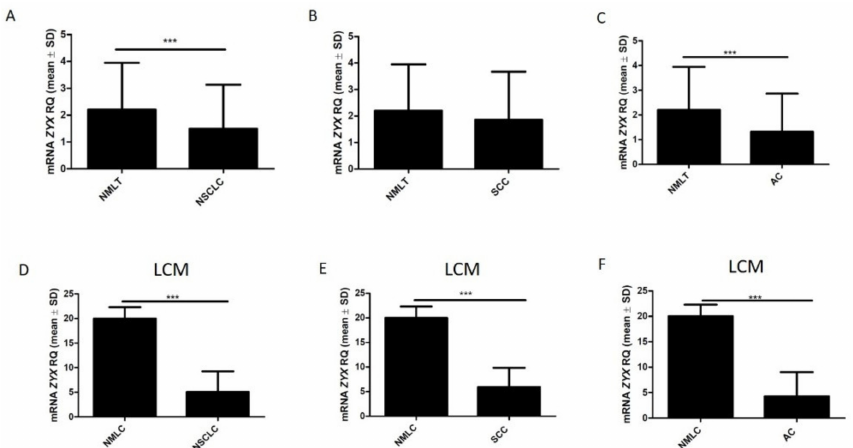
Figure 7. ZYX mRNA levels in NSCLC ( A ), lung SCCs ( B ), and lung ACs ( C ) compared with control tissue as determined by real-time PCR. Mann–Whitney test (*** p < 0.001). ZYX mRNA levels were determined by real-time PCR reactions performed on isolated NSCLC cells ( D ), lung SCC cells ( E ), lung AC cells ( F ), and non-malignant lung cells (NMLCs). Cell isolation was performed by laser capture microdissection (LCM). Unpaired t test (*** p <